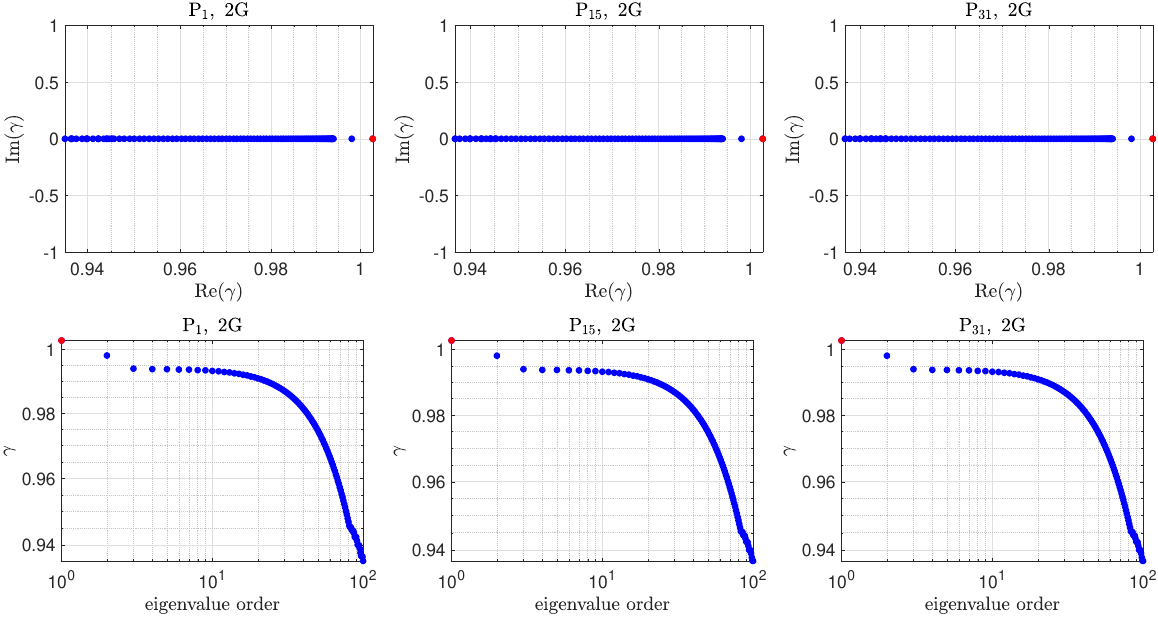
Figure 5: γ eigenvalue distribution for a symmetrically reflected